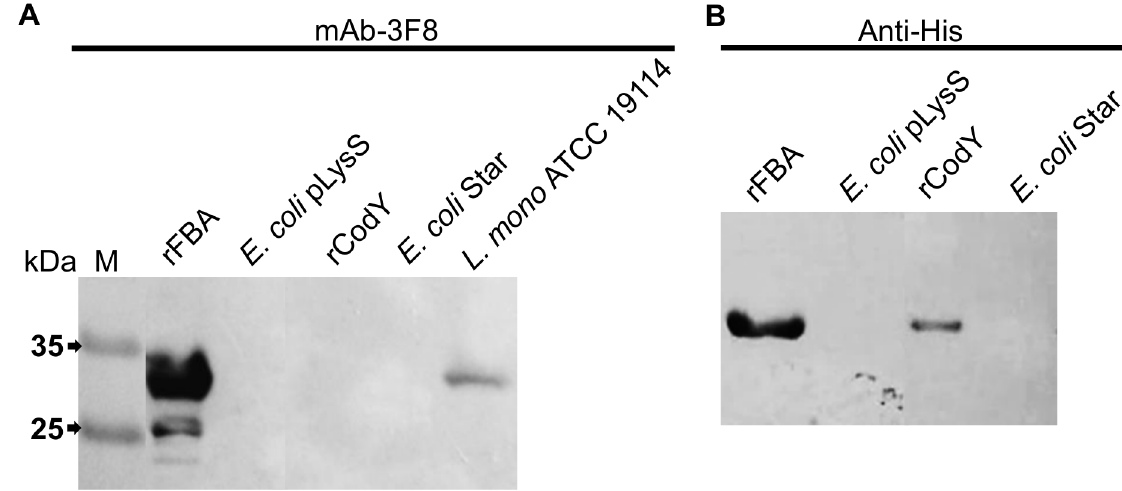
Fig 1. Western blot assay with recombinant rCodY and rFBA proteins to determine the target of mAb-3F8. (A) Western blot using mAb-3F8 as primary antibody shows that this mAb reacts with purified rFBA, as well as protein extract of L . monocytogenes , but not with rCodY. (B) The reaction using Anti-His primary antibody as control shows that both rFBA and rCodY were present in detectable amounts on the